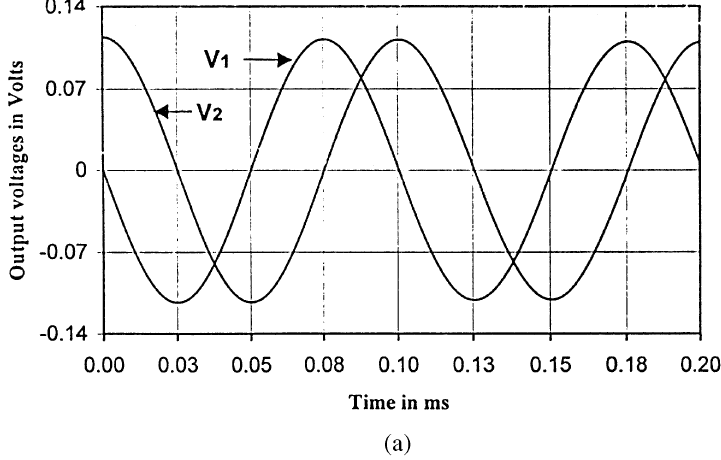
FIGURE 4 (a) Simulation-results of TGC quadrature oscillator of Figure